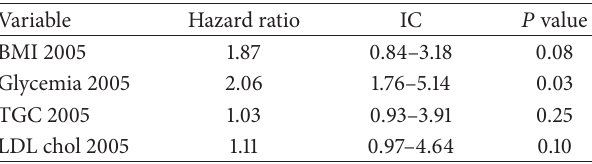
Table 4: Cox multivariate analysis for type 2 diabetes mellitus risk